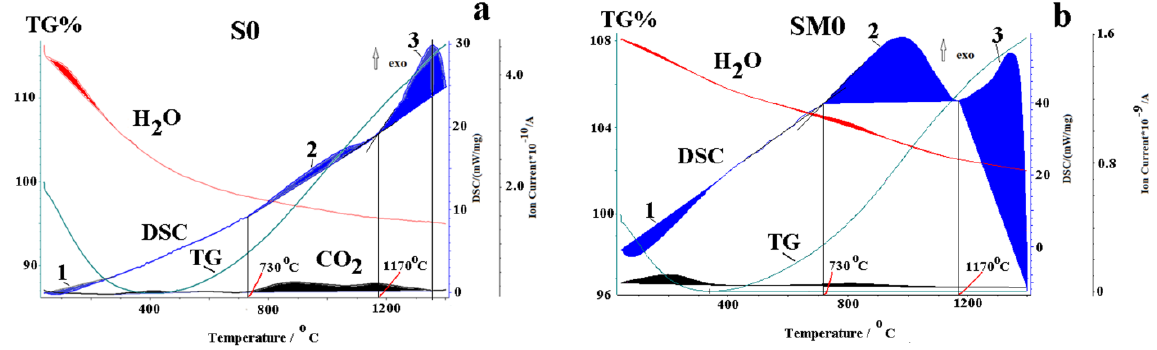
Figure 5. ( a ) Synchronous heating curves (40–1400 ◦ C, Ar) DSC-TG and H 2 O, CO 2 mass spectra of CeF 3 NP; ( b ) synchronous heating curves (40–1400 ◦ C, Ar) DSC-TG and H 2 O, CO 2 mass spectra of commercial powder CeF 3 .